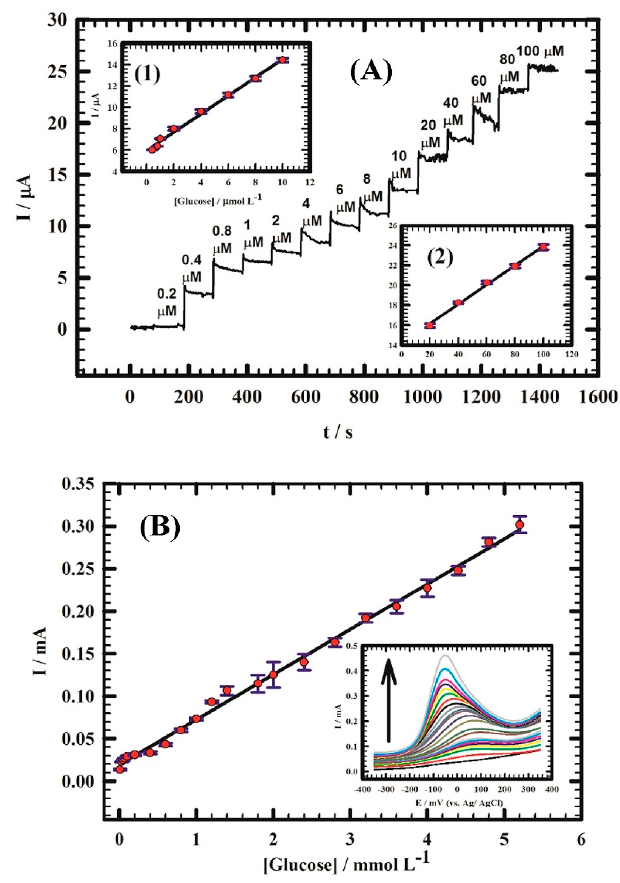
Figure 6. ( A ) Amperometric response of graphite/Sr 2 Pd 0.7 Au 0.3 O 3 with successive additions of glucose from 0.2 to 100 µM. Insets (1, 2): calibration curves for glucose for concentrations from 0.4 to 10 µM and from 20 to 100 µM, respectively. We used 0.1 M NaOH and an applied potential of − 76 mV. ( B ) Calibration curve for glucose in diluted urine for concentrations from (10–5.2 µM). Inset: Linear sweep voltammetry (LSVs) of 10 mL of diluted urine at graphite/Sr 2 Pd 0.7 Au 0.3 O 3 in different concentrations of glucose (10–5.2 mM; reproduced with the permission from reference [121]).